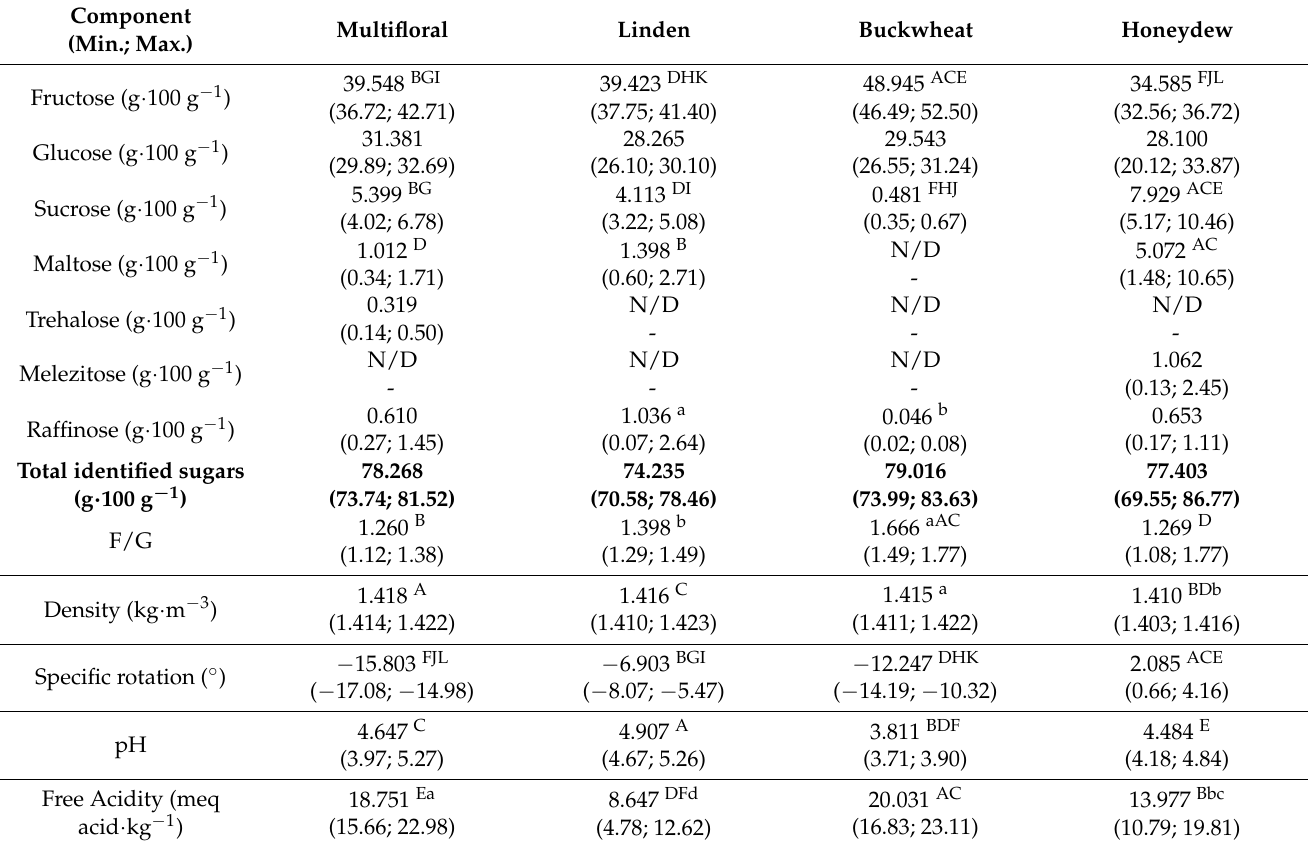
Table 2. Comparison of sugar composition and some physicochemical properties of different types of honey.